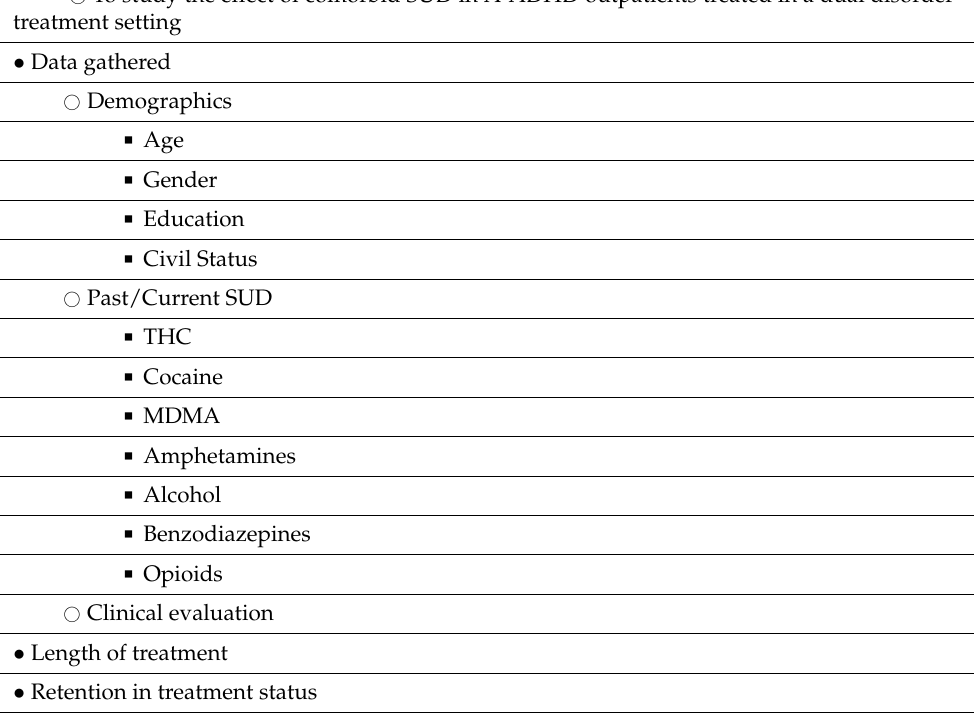
Table 1. Aim and data